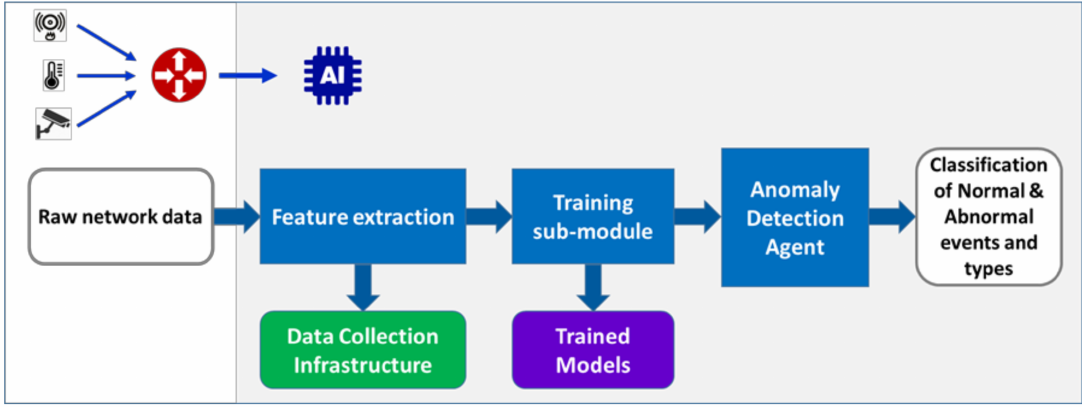
Figure 2. Dataflow for the cross-layer anomaly detection module.